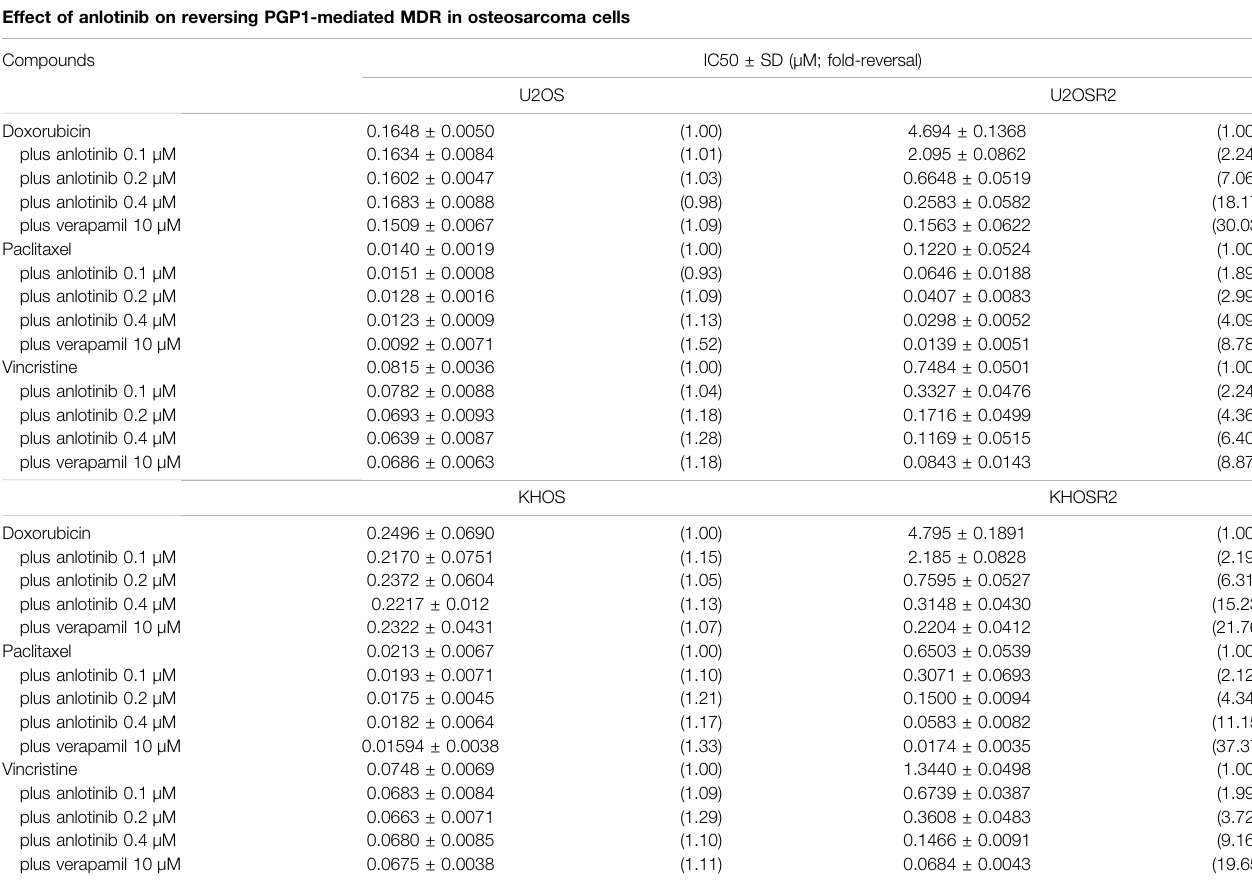
TABLE 1 | Ability of anlotinib to reverse drug resistance in multidrug-resistant osteosarcoma cell lines. Effect of anlotinib on reversing PGP1-mediated MDR in osteosarcoma cells Compounds